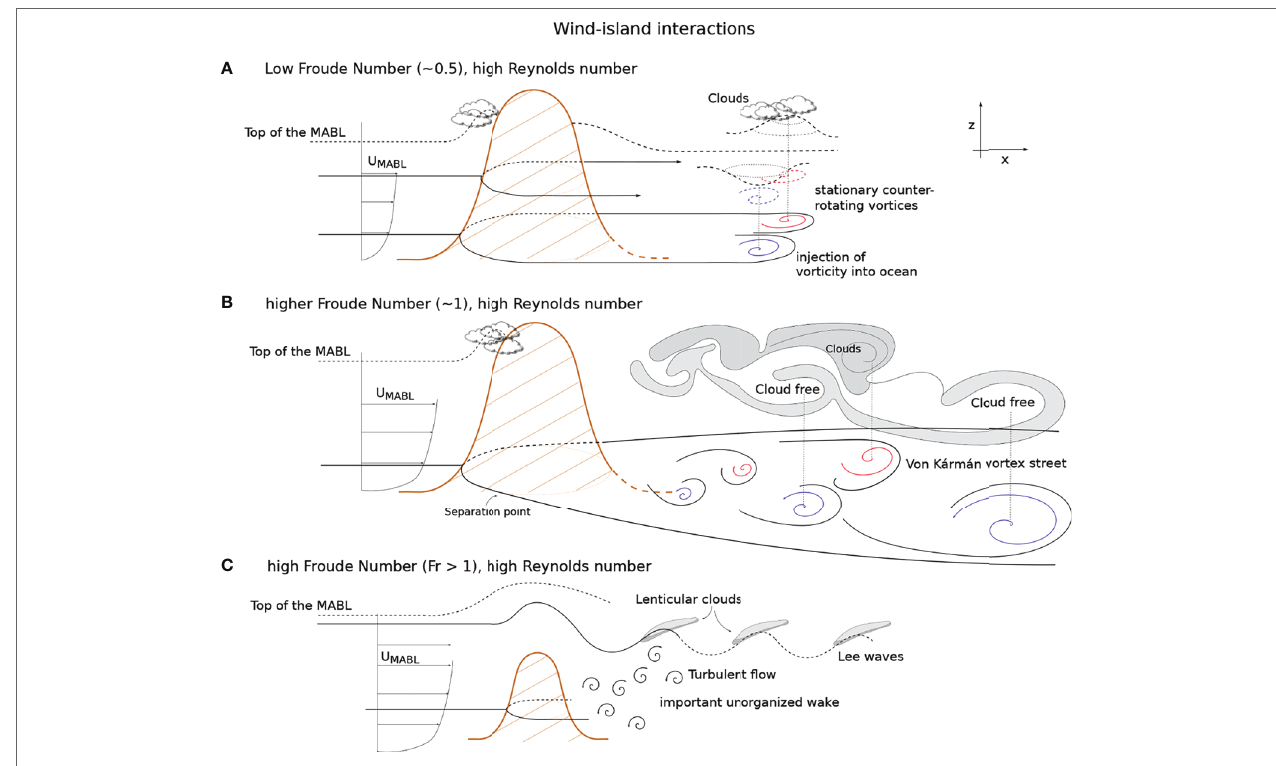
0.5, (B) Fr 1 and (C) higher Froude ∼ ∼